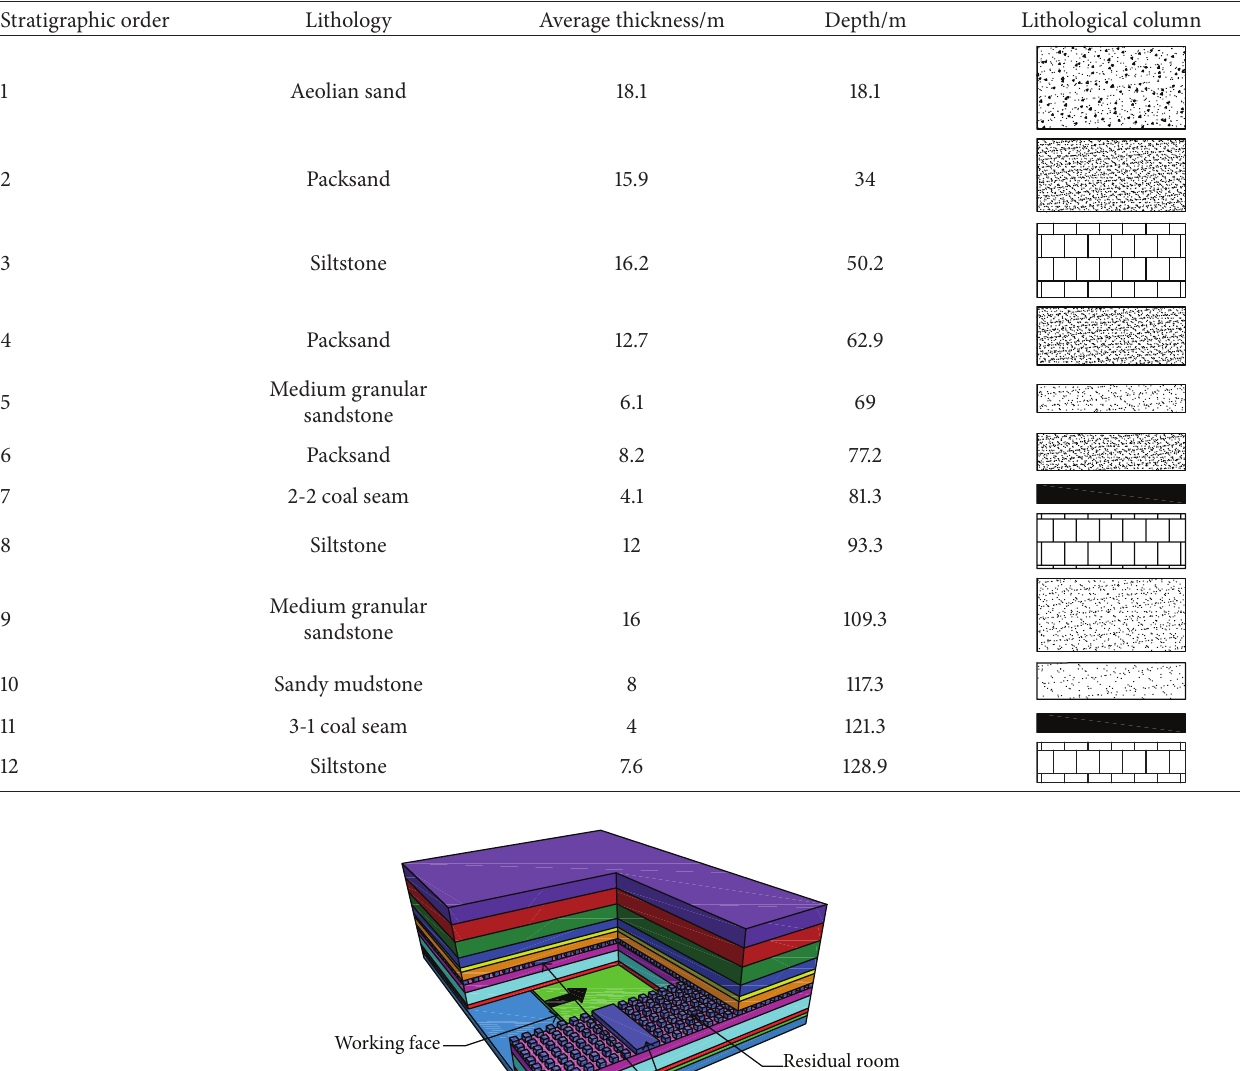
Table 1: Stratigraphic column of Shigetai mine.